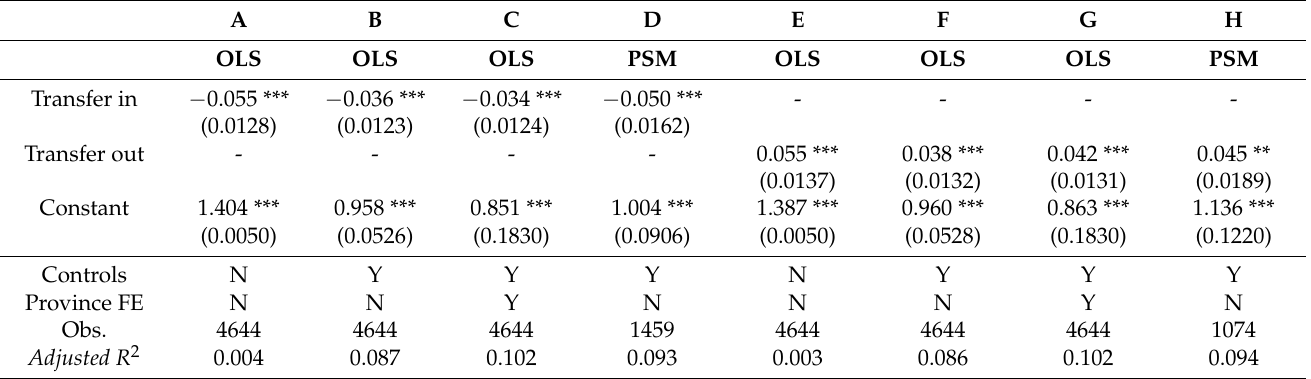
Table 6. Shannon index.